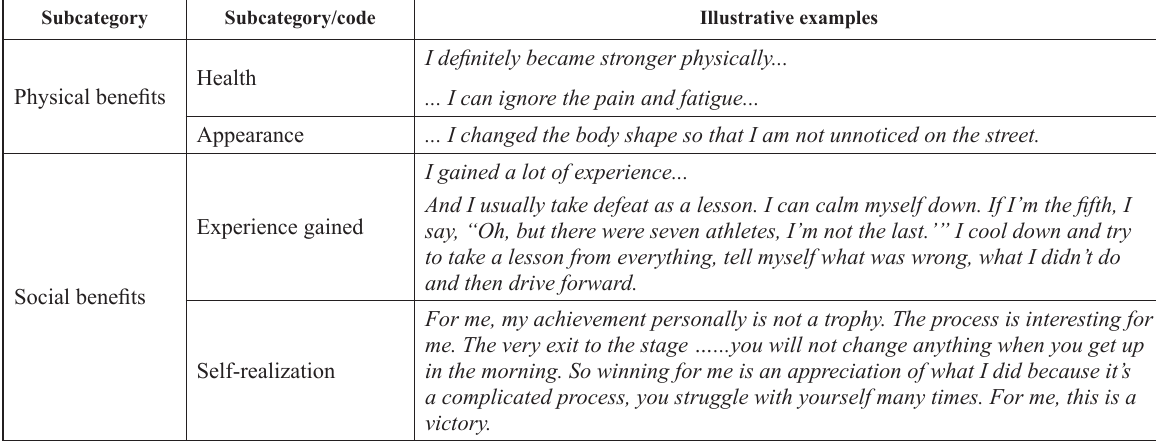
Table 2. Category: Benefits of bodybuilding sport